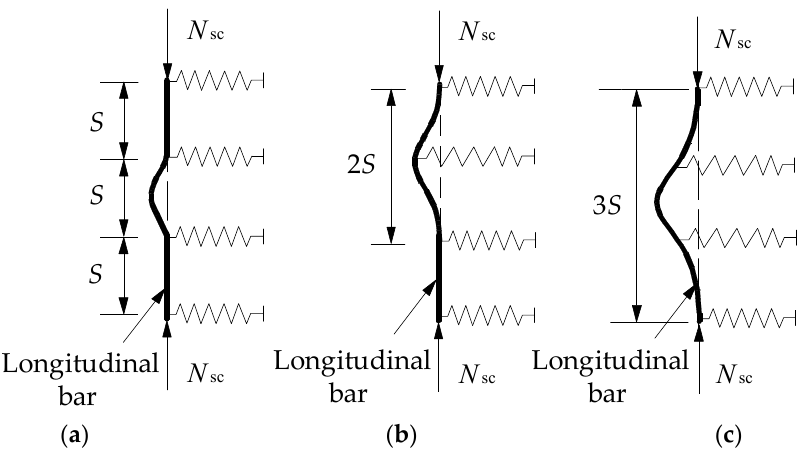
Figure 14. The flexural mode of longitudinal reinforcing steel bars. ( a ) 1st order flexure mode. ( b ) 2nd order flexure mode. ( c ) 3rd order flexure mode.